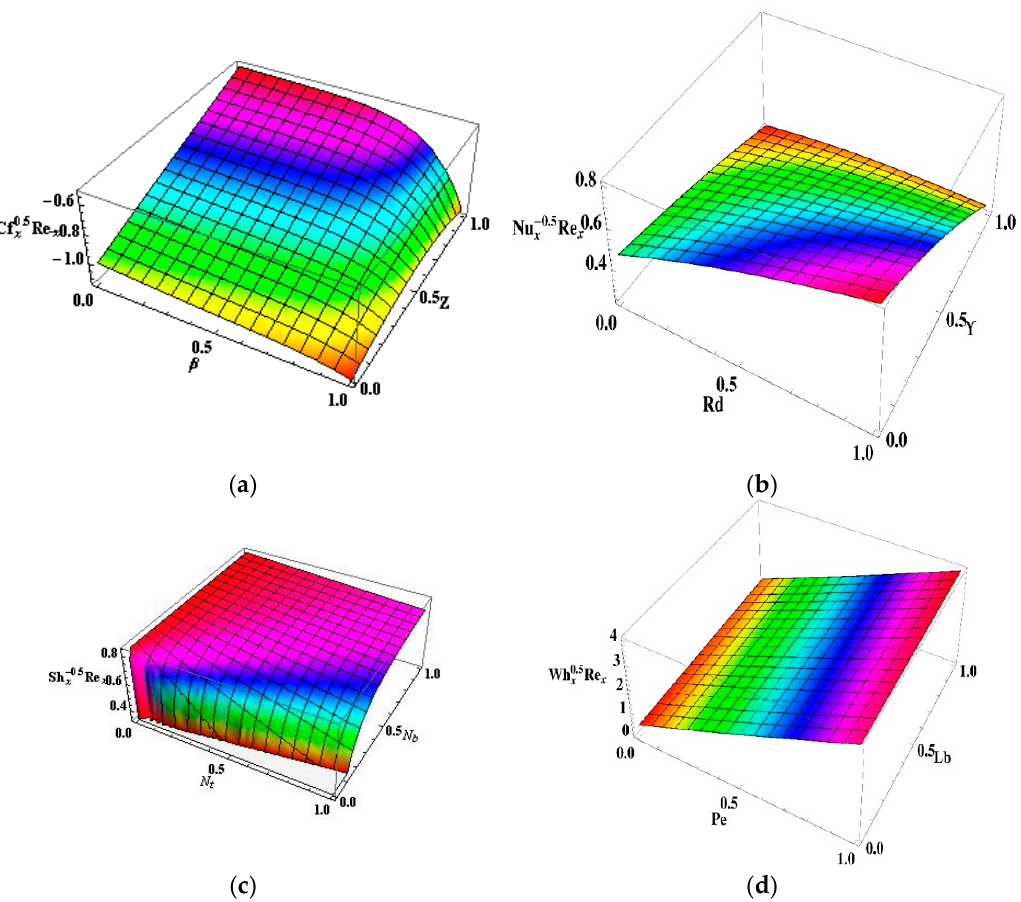
Figure 10. ( a – d ) Three ‐ dimensional graphs; ( a ) Skin friction for 𝛽 and 𝑍 ; ( b ) Nusselt number for 𝑅𝑑 and ϒ; ( c ) Sherwood number for 𝑁𝑡 and 𝑁𝑏 ; and ( d ) motile density for 𝑃𝑒 and 𝐿𝑏 .